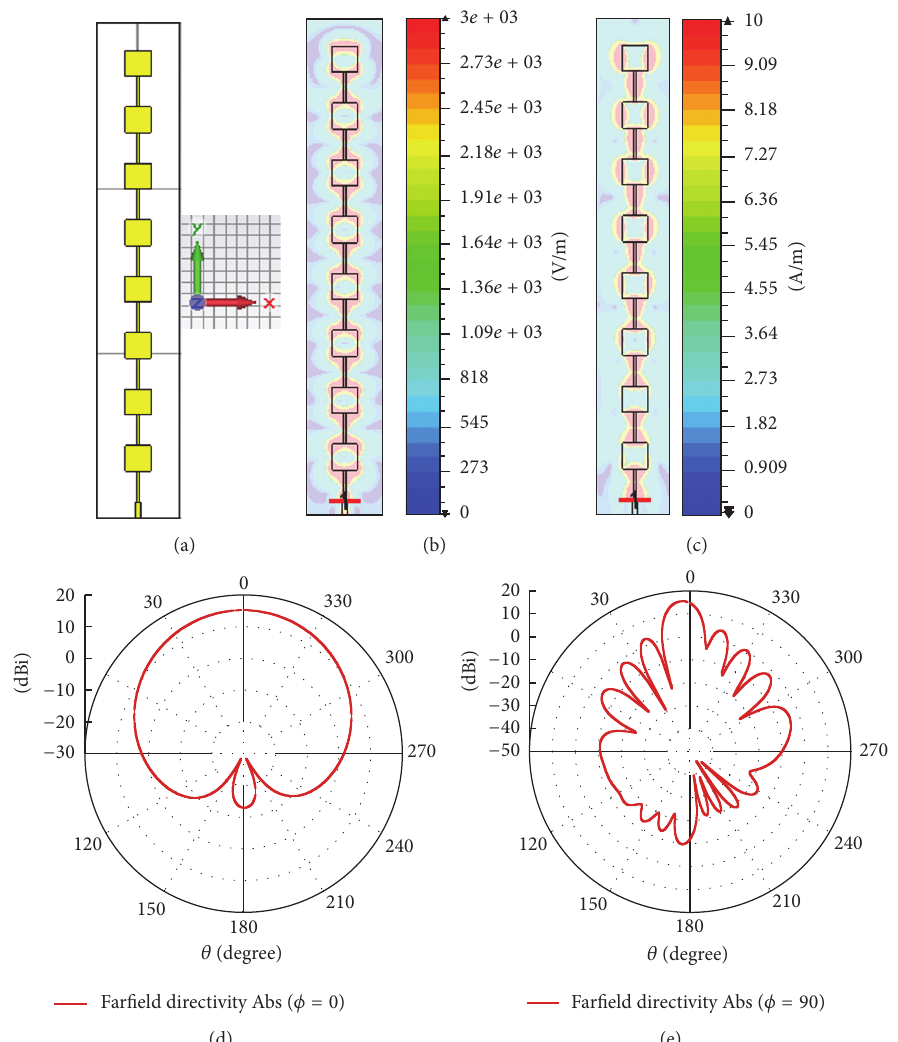
Figure 5: Serial array with 8-patch geometry (a); 𝐸 𝑧 field distribution (b) and 𝐻 𝑧 field distribution (c) on the patch plane ( x - y ); sagittal ( x - z ) (d) and azimuthal ( y - z ) (e) radiation